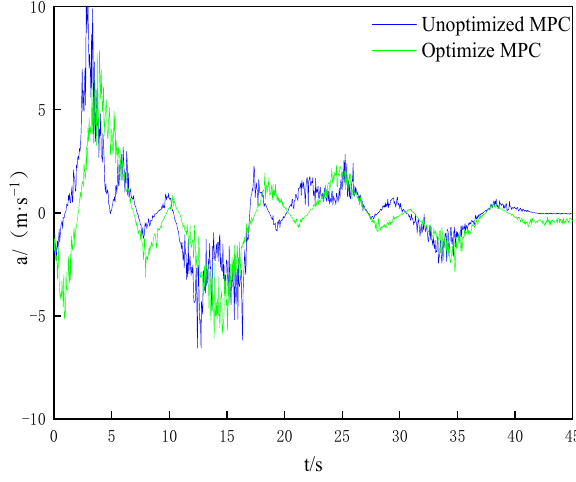
Figure 10. Acceleration test results.